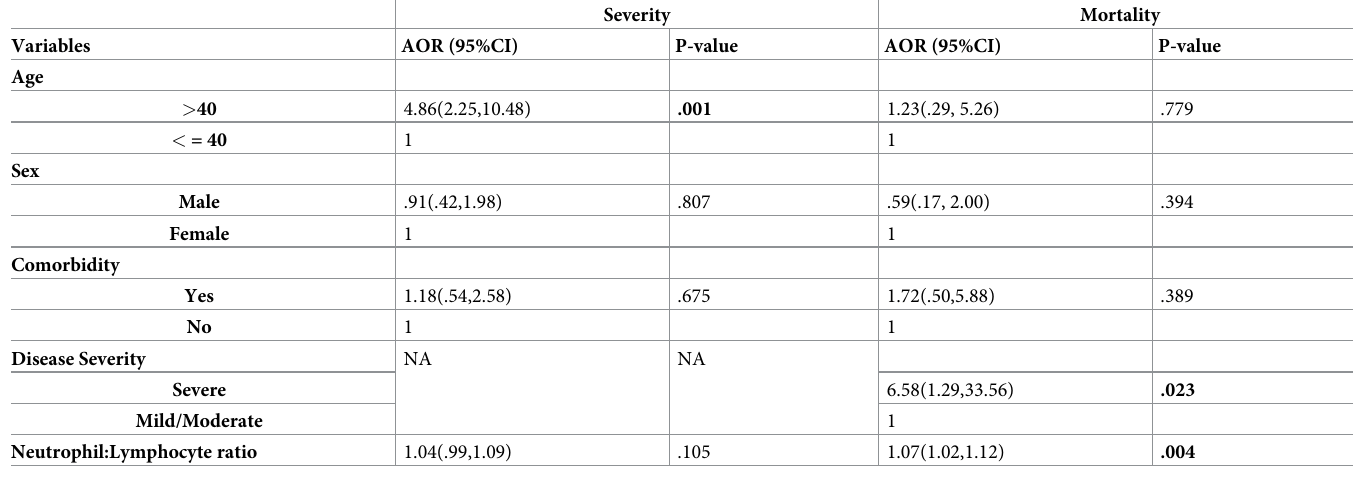
Table 4. Association of sociodemographic features, clinical history, laboratory profile with severity and mortality among COVID-19 patients (n = 126).